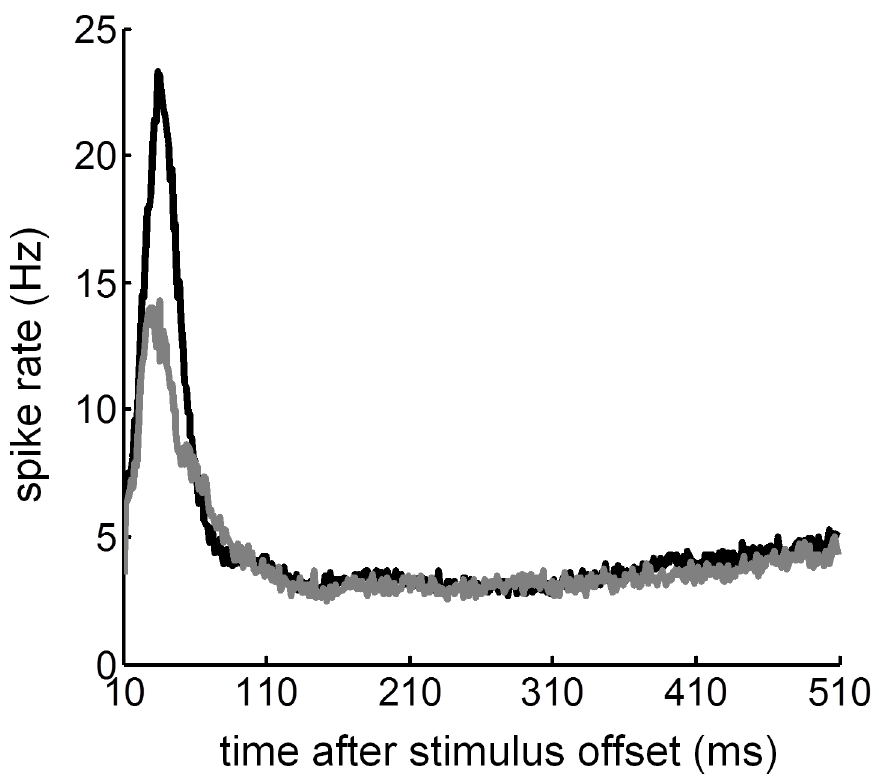
Figure 12. Average post-stimulus time histogram from deaf animals with cochlear implants. Average post-stimulus time histogram across the population of units in response to SAM (black line) and HWR pulse trains (grey line). Note the x-axis plots time after the stimulus offset.